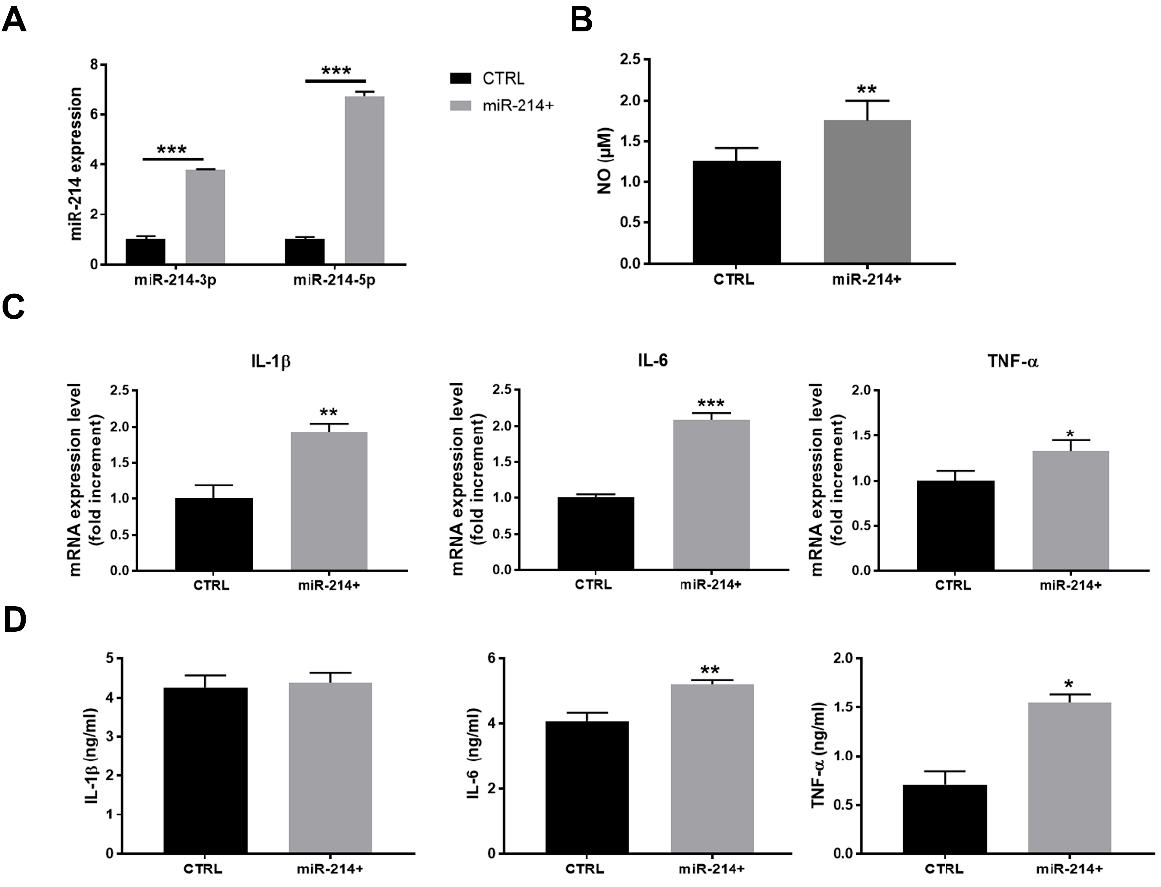
Figure 4. miR-214 over-expression induced the proinflammatory activation of RAW 264.7 macrophages. ( A ) Real-time qPCR of miR-214-3p/5p in RAW 264.7 macrophages where miR-214 was over-expressed compared to control cells (two-way ANOVA). ( B ) NO concentration in CM of control or miR-214-overexpressing RAW 264.7 macrophages ( t -test). ( C ) Real-time qPCR of IL-1 β , IL-6, and TNF- α mRNA in the control and miR-214-overexpressing RAW 264.7 macrophages ( t -test). ( D ) ELISA of IL-1 β , IL-6, and TNF- α released in CM of the control or miR-214-overexpressing RAW 264.7 macrophages ( t -test). * p < 0.05, ** p < 0.01, and *** p < 0.001.